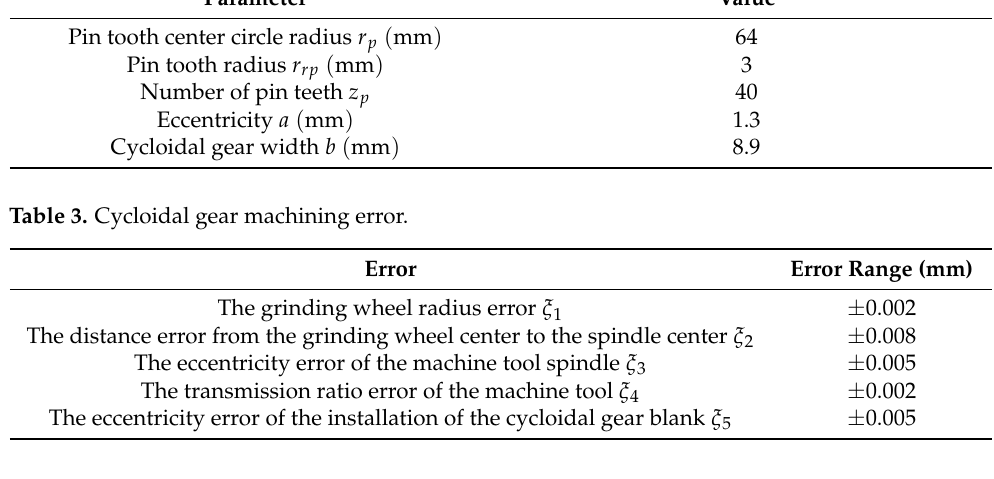
Table 3. Cycloidal gear machining error.